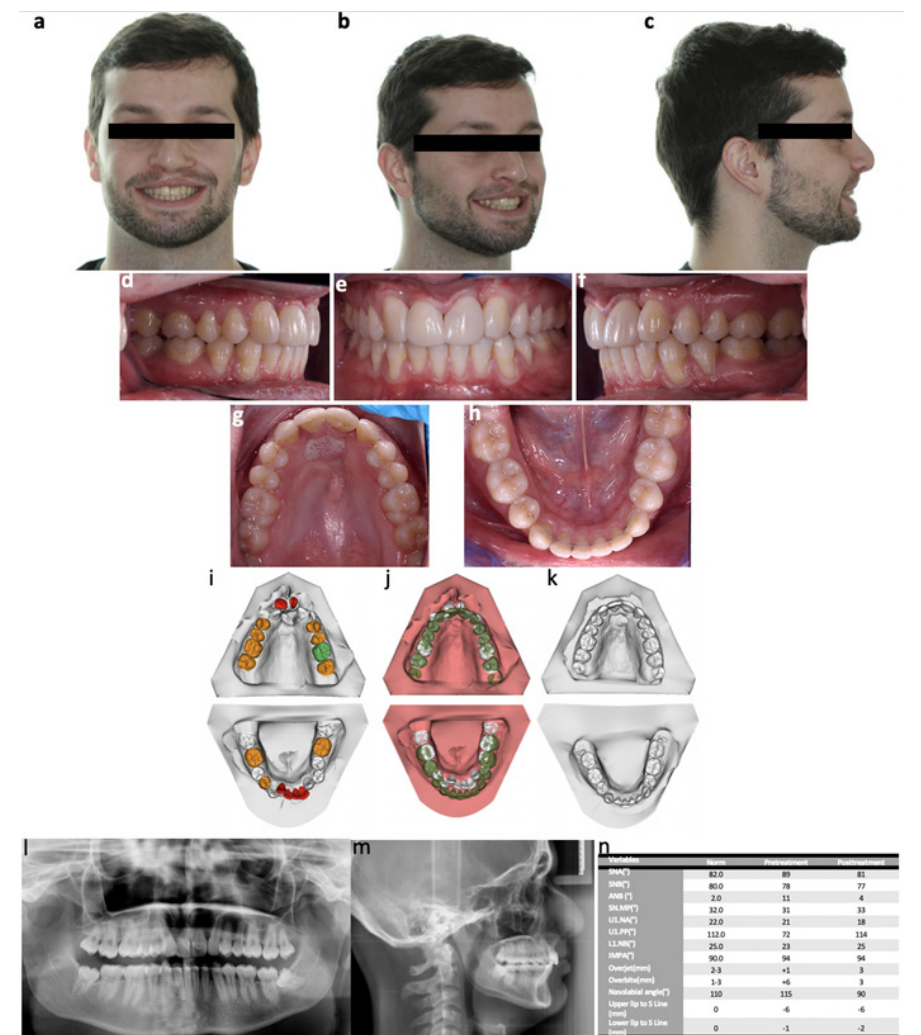
Figure 6. Post-treatment records: extraoral photographs ( a ) frontal view; ( b ) 3/4 lateral view; ( c ) profile; oral photographs ( d ) right side; ( e ) frontal; ( f ) left side; ( g ) superior arch; ( h ) inferior arch; dental casts ( i ) initial; ( j ) superimposition; ( k ) final; ( l ) final orthopantomography; ( m ) final lateral cephalogram; ( n ) cephalometric